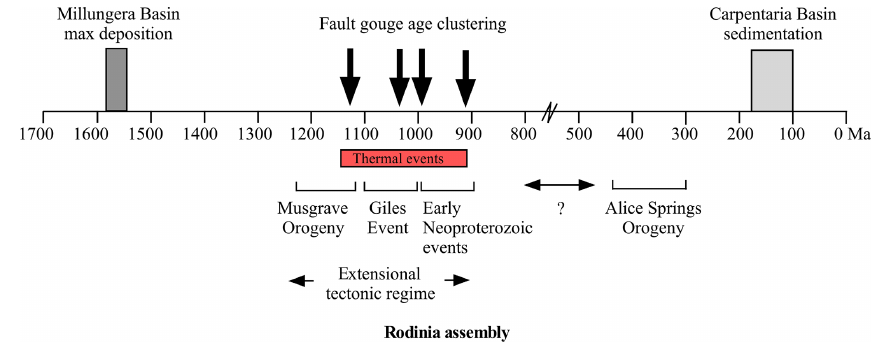
Figure 12. Summary of the geological history of the Millungera Basin region and isotopic age clusters of the